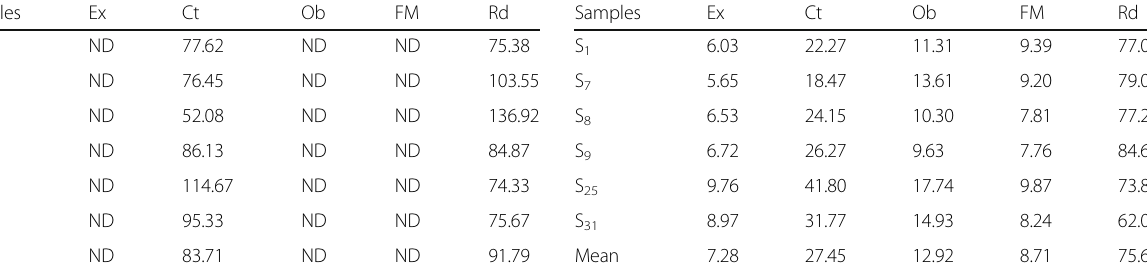
Table 6 Chromium fractionation results (ppm)